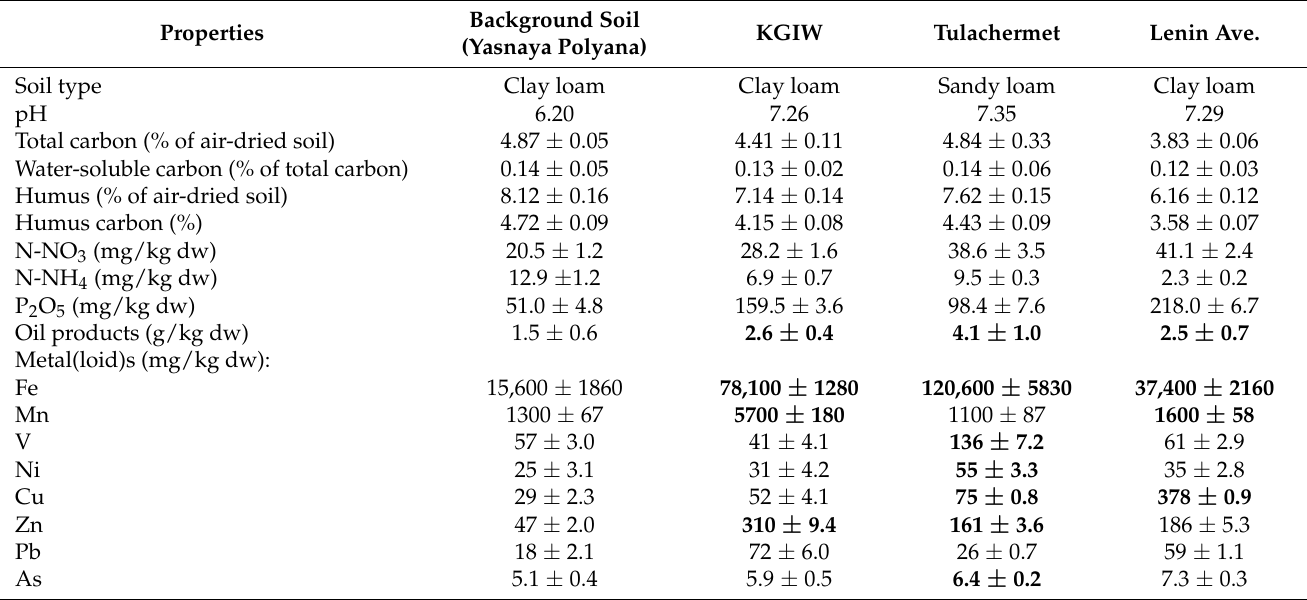
Table 1. Characteristics of the soils used in the